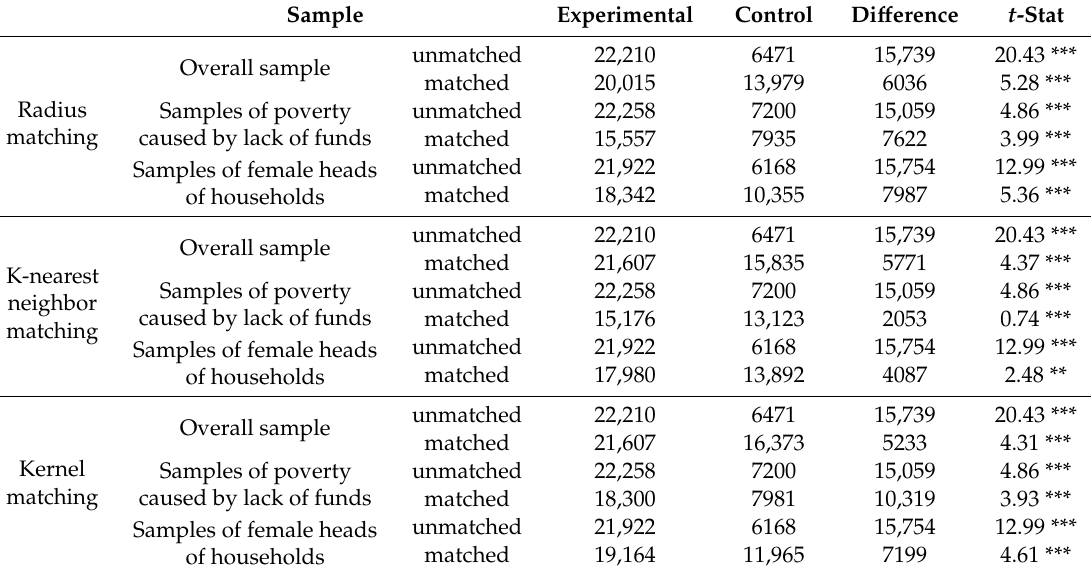
Table 5. The e ff ects of the poverty alleviation microcredit policy on the production income of poor